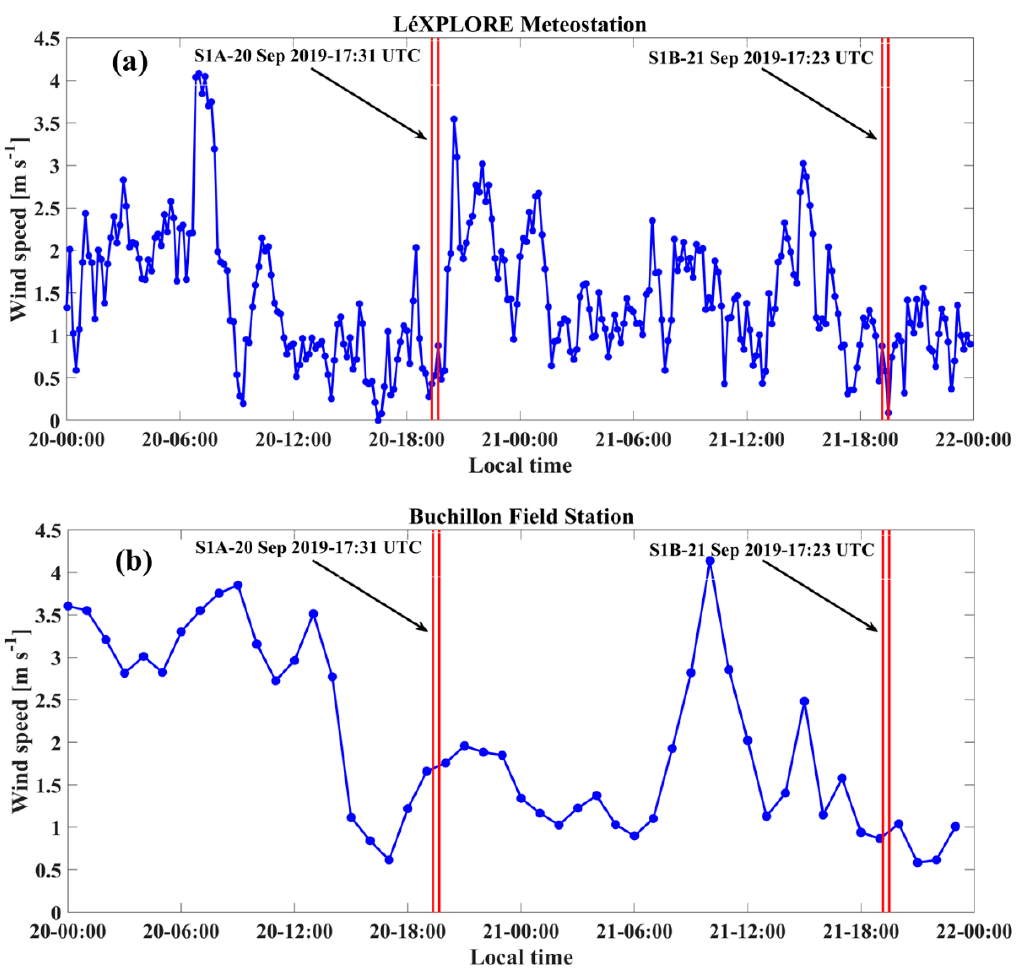
Figure 11. Wind speed measured at the ( a ) LéXPLORE and ( b ) Buchillon stations during 20–21 Sep- tember 2019. For locations, see Figure 1. Red parallel lines: times when SAR satellite images were